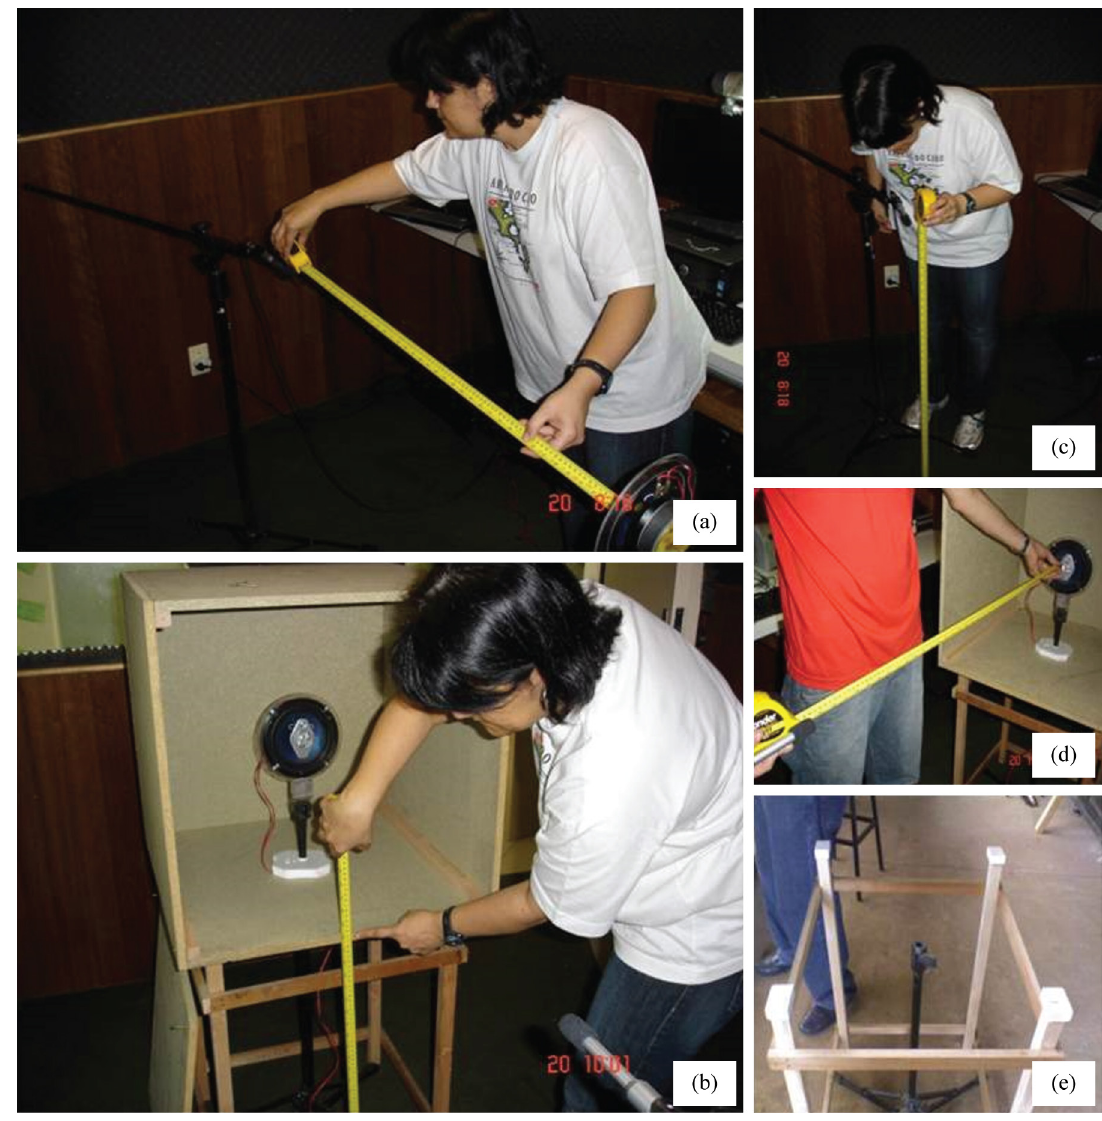
Figure 4. Photos of the assembly of the experiment; (a) Positioning for characterization of the source of noise; (b), (c) and (d) Positioning with the modules and (e) Rubber buffer